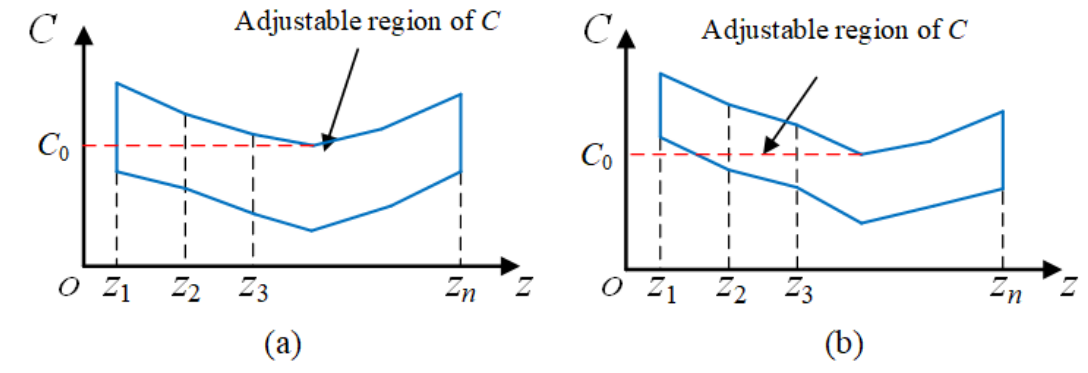
Figure 11. The adjustable region of C : ( a ) the adjustable region of C for situation 1, ( b ) the adjustable region of C for situation 2.